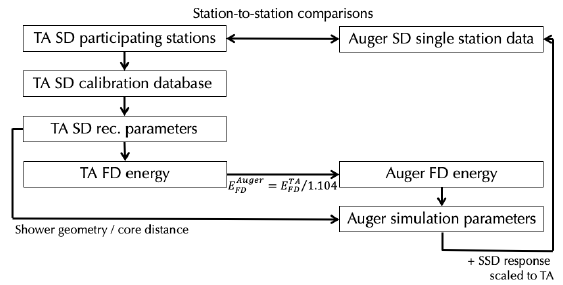
Figure 4. Analysis chain allowing for a test of the consistency of the Auger and TA data collected by Auger@TA phase I (see text for details).